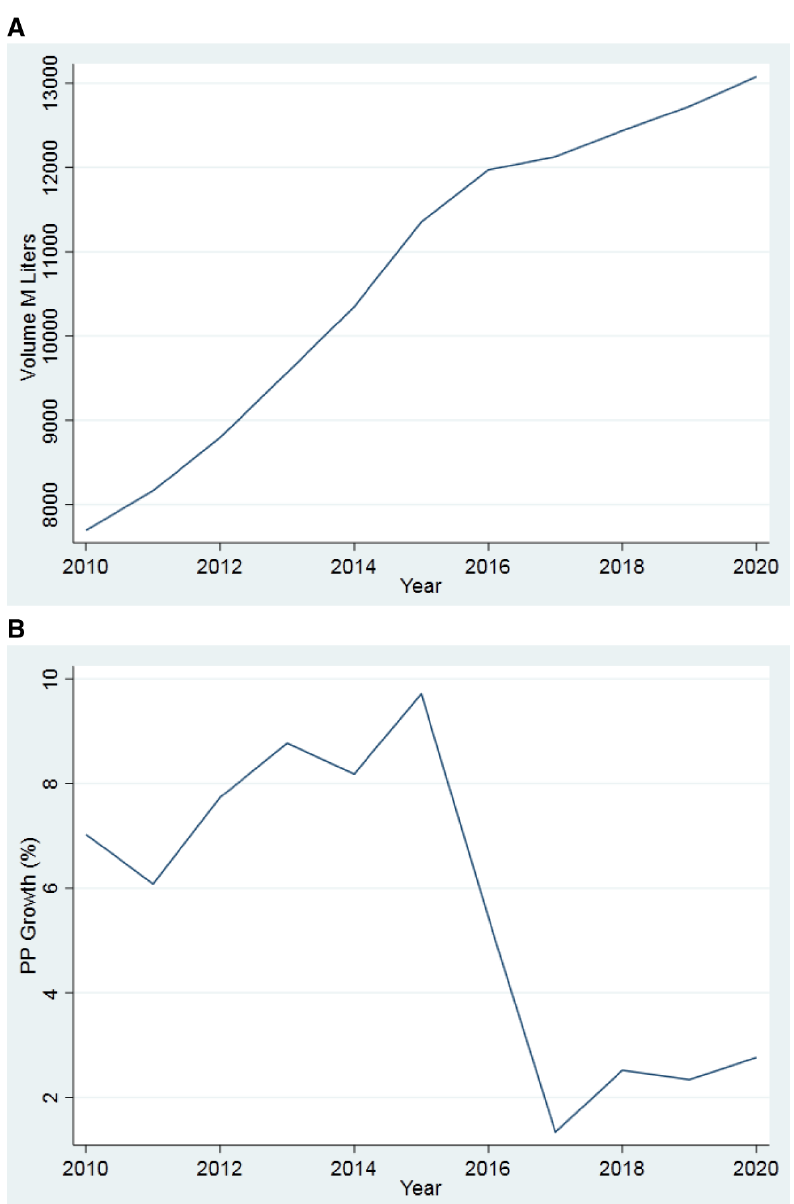
Figure 1. Sales volume of soft drinks in Saudi Arabi from 2010–2020. ( a ) Sales volume in million liters; ( b ) percentage growth from previous period (PP growth %).